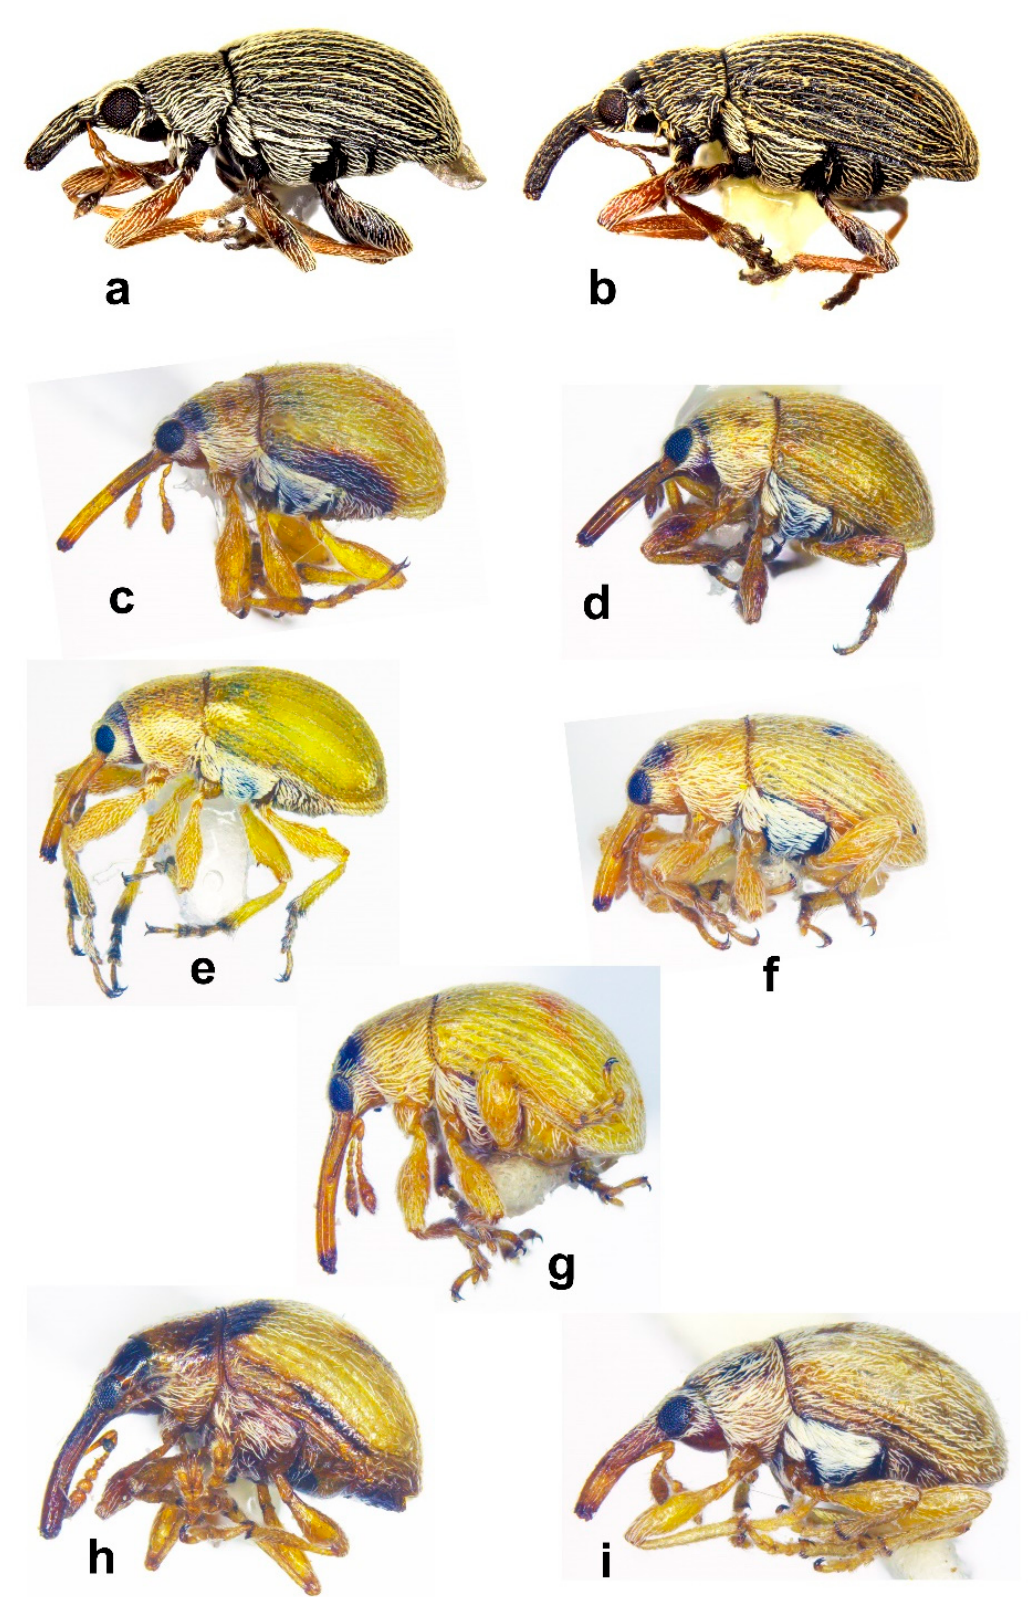
Figure 6. Habitus in lateral view of ( a ) Squamapion delagrangei , male; ( b ) Squamapion delagrangei , female; ( c ) Allomalia quadrivirgata , female; ( d ) Allomalia setulosa , female; ( e ) Corimalia latifrons , female; ( f ) Corimalia schatzmayri , male; ( g ) Corimalia torretrassoi , female; ( h ) Nanomimus sp., male; ( i ) Nanophyes sp. 1, male (not on the same scale).